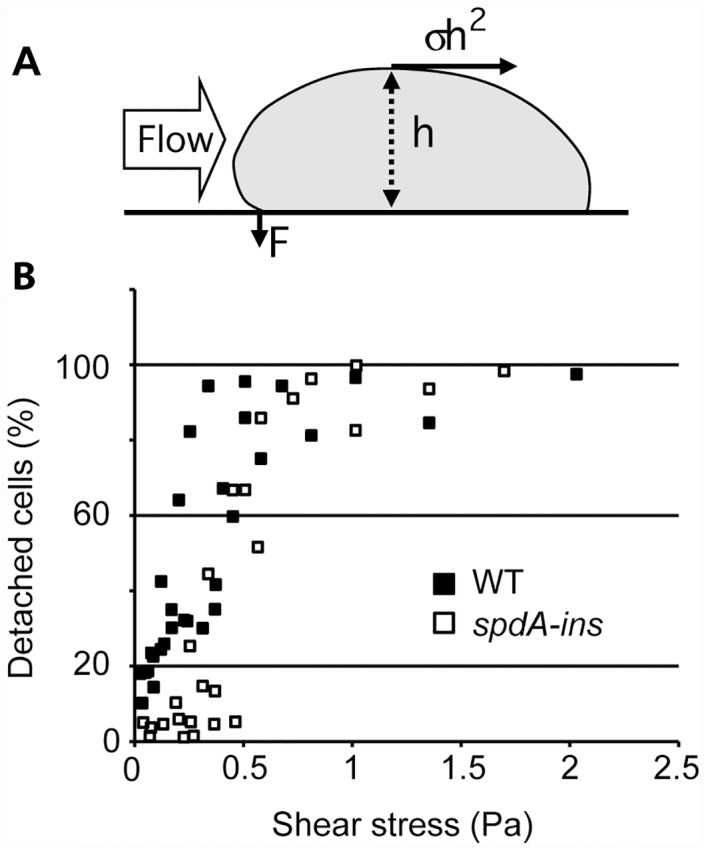
SpdA-ins cells adhere more efficiently than WT cells to their substrate.(A) Side view of a cell attached to its substrate and exposed to a flow of medium. The adhesion of the cell to its substrate can be assessed by determining the speed of a flow of medium that is necessary to detach the cells [19]. The strength applied by the flow of medium on the cell is σh2, and its mechanical moment (σh3) is balanced by the adhesive force (F). Inspired from [18]. (B) Percentage of detached cells as a function of the applied shear stress. At a low flow (between 0 and 0.5 Pa), spdA-ins cells detached less readily than WT cells from the substrate. At higher flow (>0.5 Pa) no significant difference can be seen between WT cells and spdA-ins cells. Data from three independent experiments is represented in this graph. A decrease in cell detachment can be the result of an increase in the adhesion force (F) or of a decrease in h (i.e. of a more efficient cell spreading).